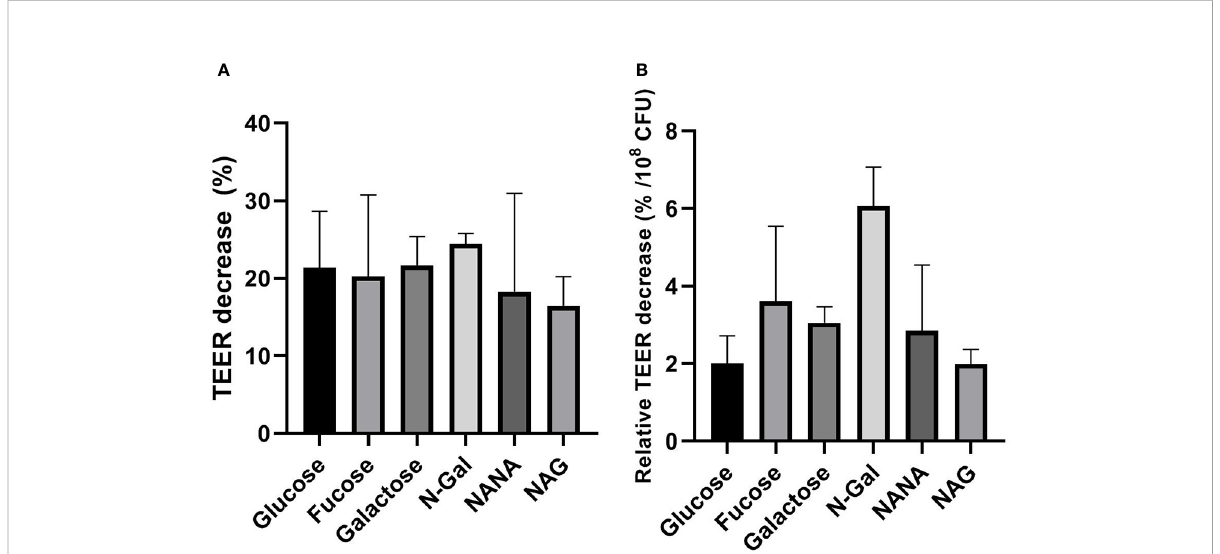
FIGURE 5 In fl uence of mucus-derived metabolites on transepithelial resistance (TEER) decrease of HCT-8 monolayers caused by E. coli O157:H7. E. coli O157:H7 D stx2 + 100 ng/ml Stx2 cultures were coincubated with HCT-8 monolayers grown on Milicell supports in M9 medium supplemented with 10 mM mucus-derived metabolites (Fucose, Galactose, N-Gal. NANA or NAG) or Glucose at 37°C for 5 h in a humidi fi ed 5% CO 2 incubator. (A) Percentage decrease of TEER after treatments. (B) Percentage TEER decrease after treatments relative to bacterial density measured in the apical chamber after treatments, expressed as percentage decrease per 10 8 CFU. Data shown as mean ± SEM. No signi fi cant differences were found between treatments (p > 0.05, n =